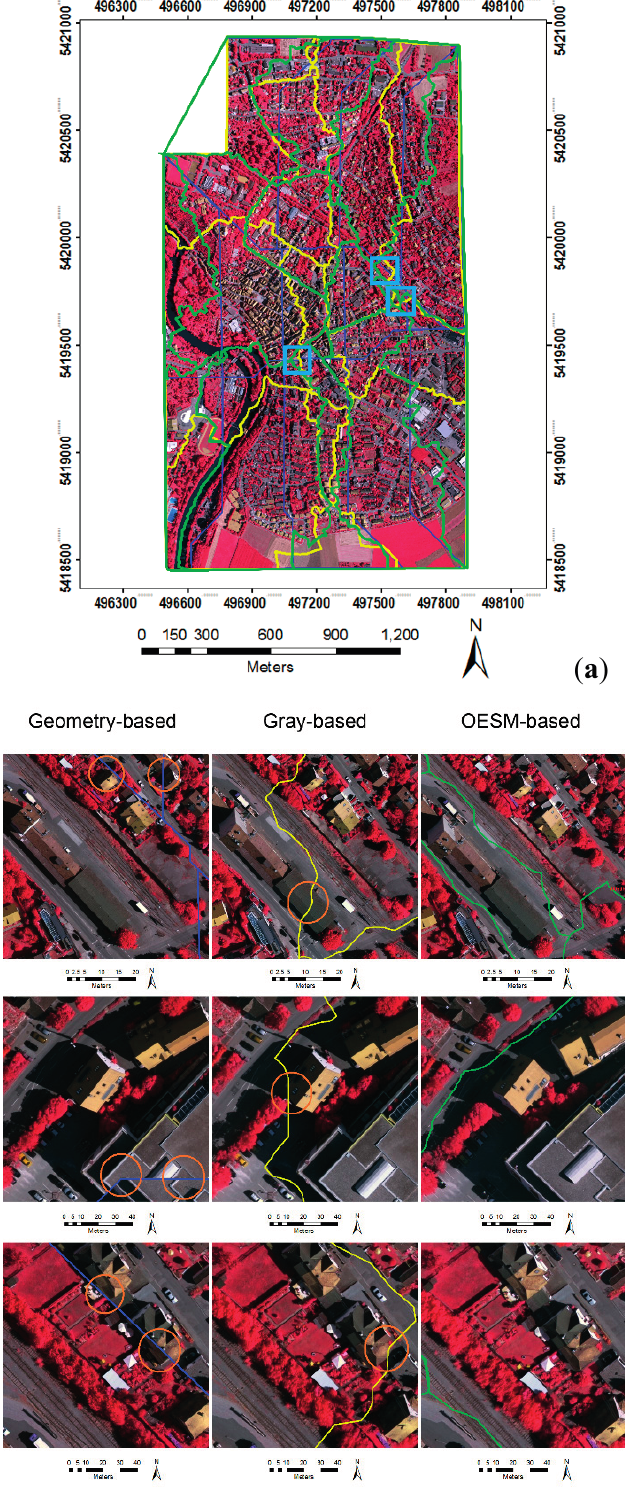
Figure 12. Mosaic results of the three methods for Dataset 2. ( a ) Overview of the mosaicked images. The blue lines are the seamlines constructed through the geometry-based method; the yellow lines are the seamlines constructed through the gray-based method; and the green lines are the seamlines constructed through the OESM-based method. ( b ) Detailed seamlines in the cyan rectangular areas of (a) selected through the three methods. The orange circle marks the visual continuities from the